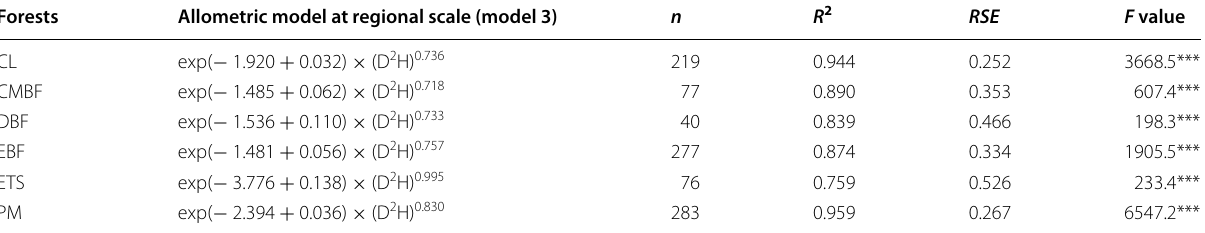
*** Indicates significant at p < 0.001 level. See Table 1 for the abbreviations of the forest types